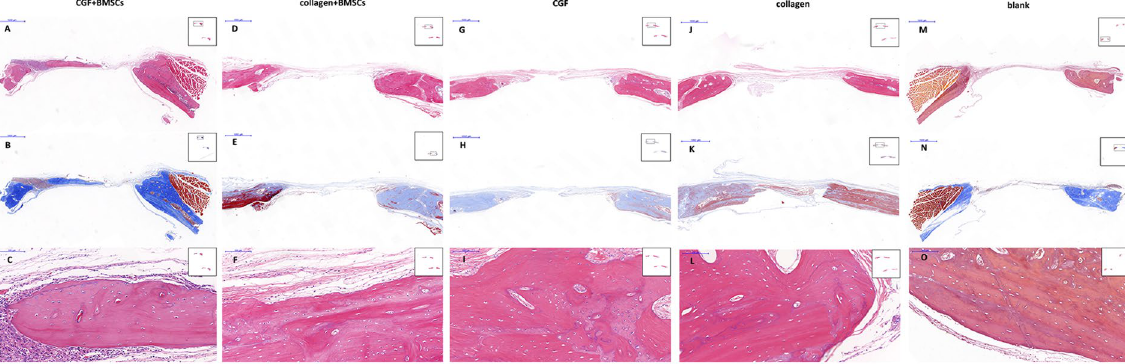
Figure 7. The microscopic histological images of cranial tissue sections of different groups, stained with H&E ( A , C,D,F,G,I,J,L , M , O ) and Masson ( B , F , H , K , N ) 6 weeks postoperatively. Newly formed bone was found both in the center and periphery of the defect site in the CGF + BMSCs group ( A , B ), this phenomenon is not observed in other groups (magnification × 20; bar 1,000 um). Neovascularization was observed around the new bone in the CGF + BMSCs group ( C ), and the structure of newly formed bone is the same as normal bone structure ( C , F , I , L , O ) (magnification × 200; bar 100 um).